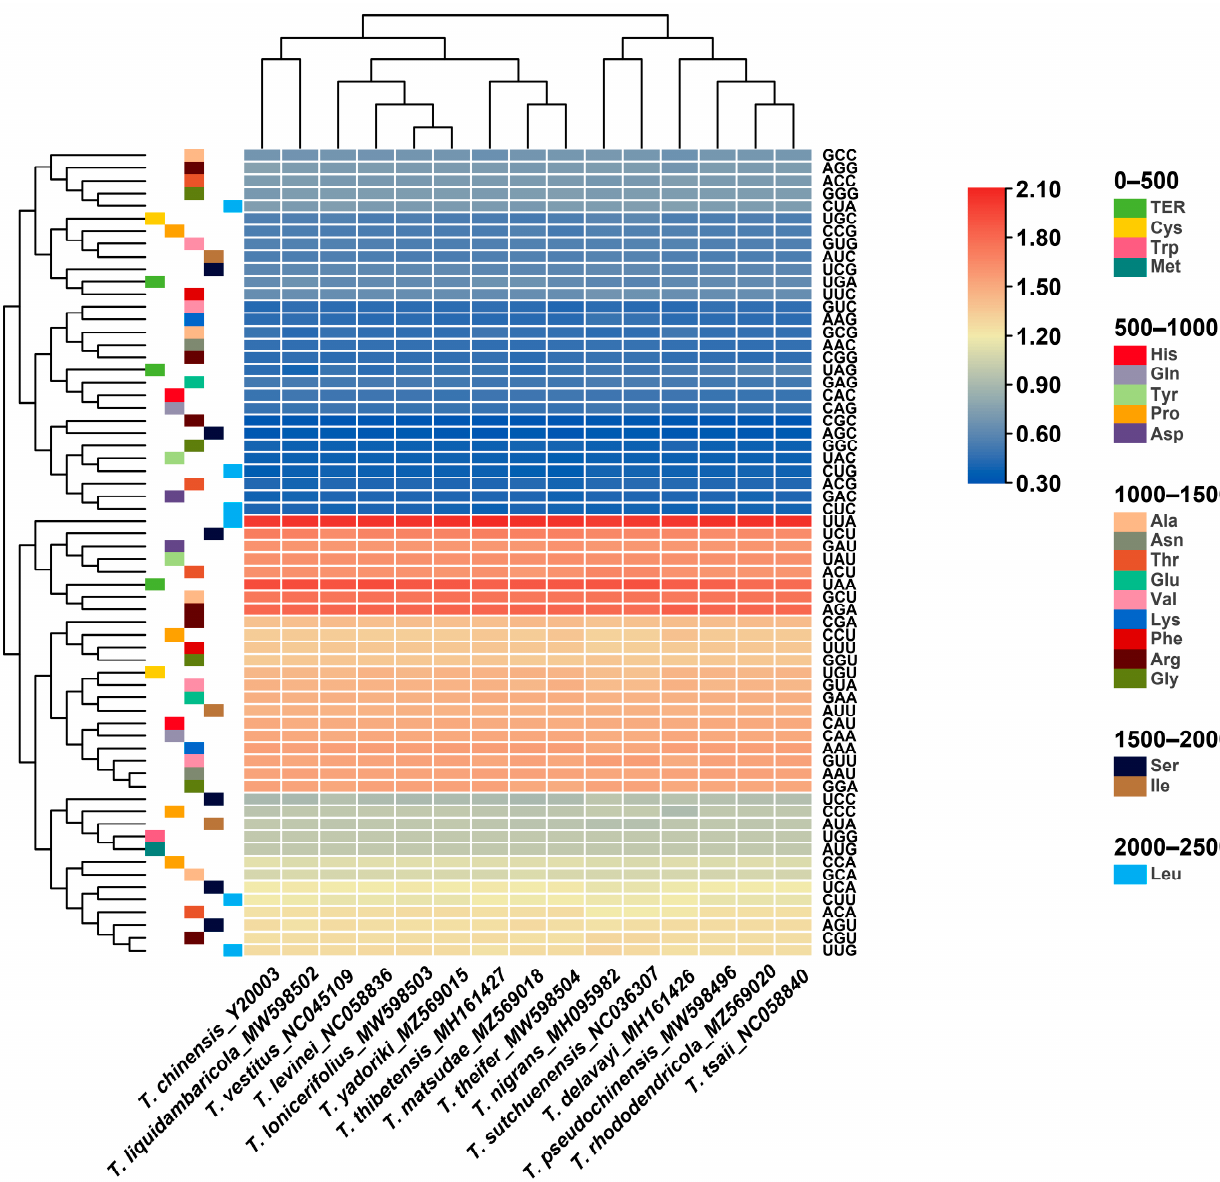
Figure 3. Heat map of RSCU values among Taxillus and Phacellaria species.